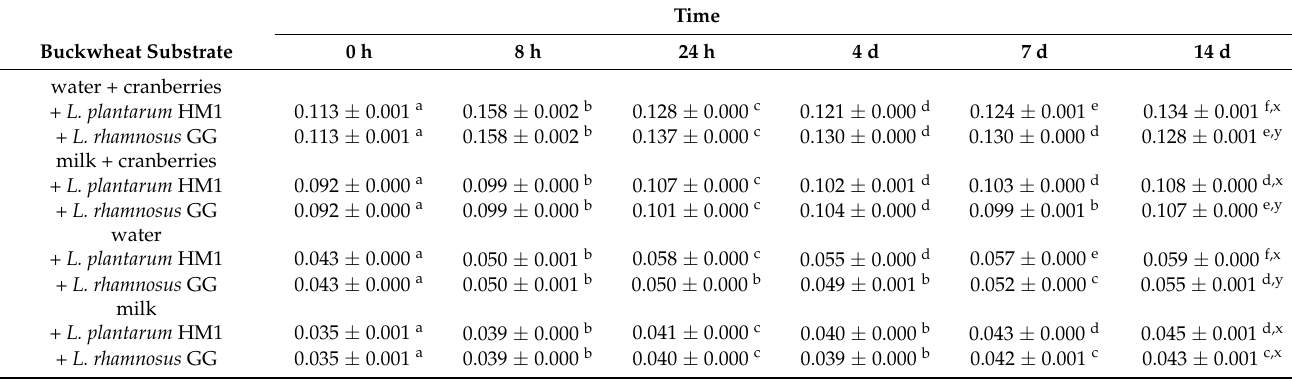
Table 3. Total flavonoid content of fermented buckwheat mashes (mg QE/g).